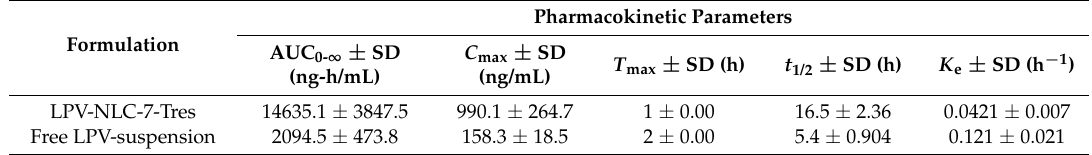
Figure 9. Comparison of LPV mean plasma concentration for 24 h following oral administration of LPV-NLC-7-Tres and LPV-suspension in rats. Mean ± S.D, n = 6. Table 8. Pharmacokinetic parameters of LPV-NLC-7-Tres and free LPV-suspension after oral